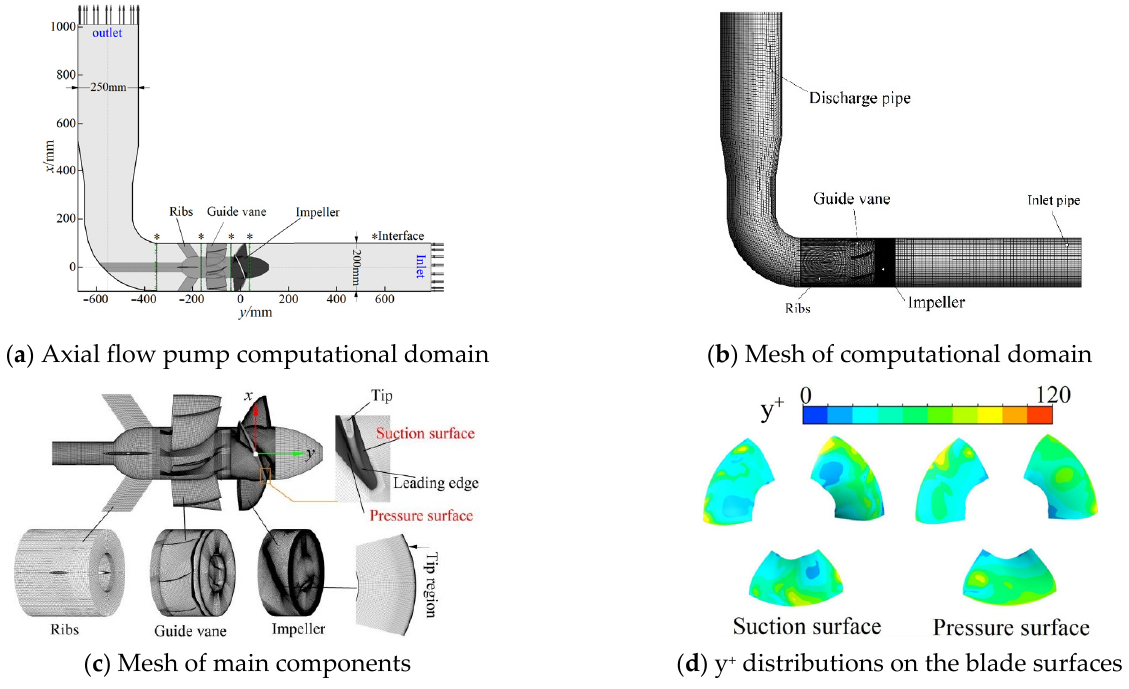
Figure 4. Computational domain, mesh of the axial flow pump, and the y + distribution on the blade surfaces.